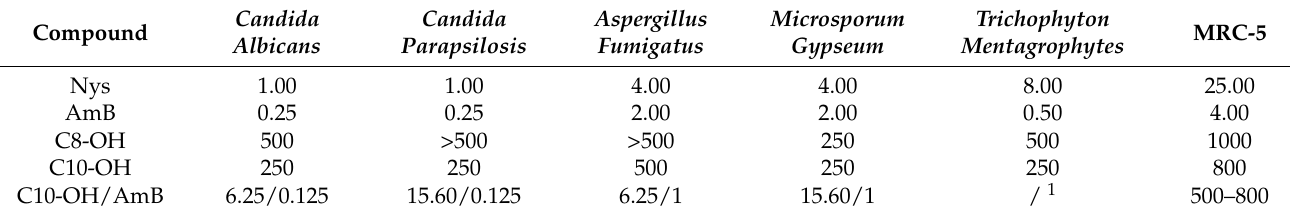
Table 1. MIC values ( µ g/mL) of polyenes, mcl-PHA monomers (C8-OH and C10-OH) and combination of C10-OH/AmB and their cytotoxicity values (IC 50 , µ g/mL) against healthy human fibroblast cell line (MRC-5).